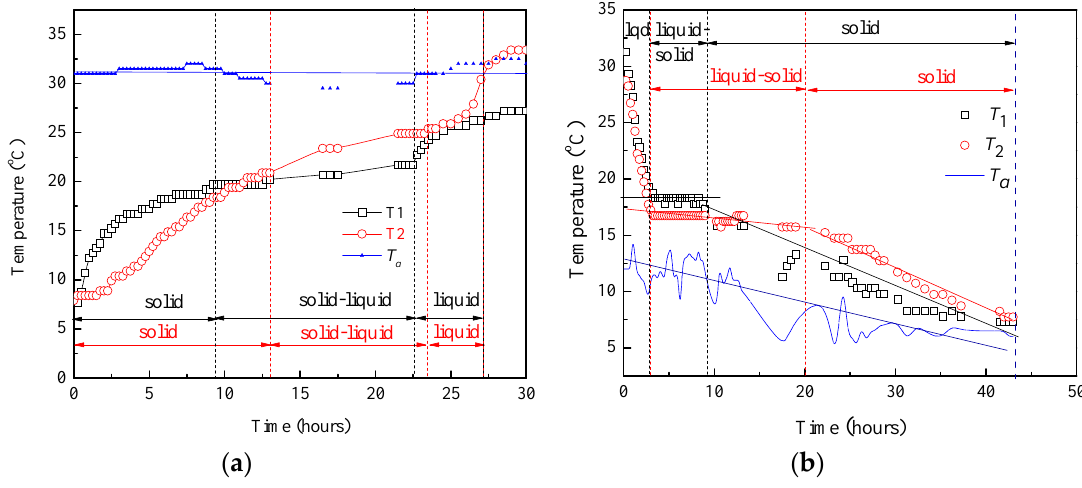
Figure 3. The time-dependent temperature curves for ( a ) melting and ( b ) solidification of co_oil samples. The regions of sensible solid heat, latency, and sensible liquid heat are each denoted by solid, solid–liquid, and liquid. The periods of those phases were different for the two thermometers as indicated by the vertical dashed line. The solid lines indicate the linear extrapolation as a guide for the eye.